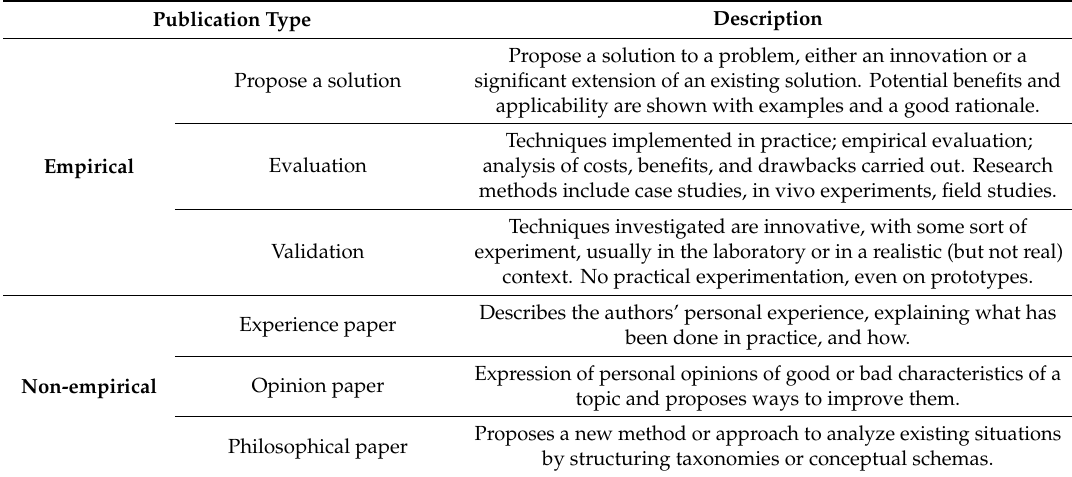
Figure 9. Distribution of papers by classification type. Table 6. Taxonomy of types of publication.